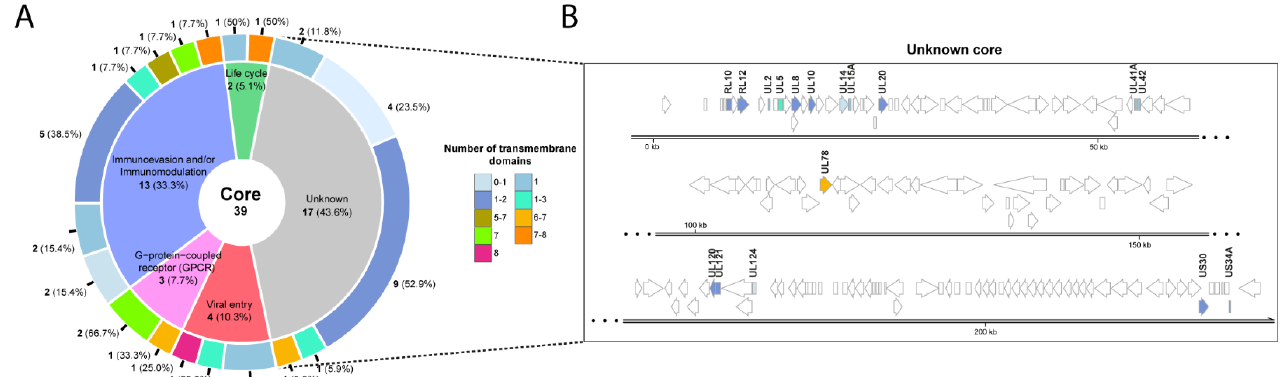
Figure 3. Functional analysis of the 39 core proteins. ( A ) Pie chart of the proteins found in all the studied strains were grouped based on their functions. For each group, the number of predicted transmembrane domains is also indicated. When the number of transmembrane domains predicted was different using the three methods, a range of values is shown. The number of proteins in each section is marked in blue and the percentage between brackets. ( B ) Genomic location of the 17 proteins with non-described